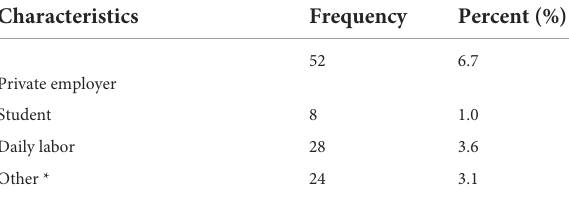
TABLE 1 Socio-demographic characteristics of women who gave birth in North Showa zone public health institutions, North Showa zone, Ethiopia, 2020 (N =